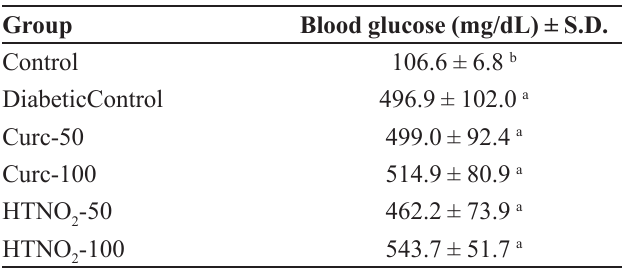
FIGURE 4 - Changes in capillary blood glucose levels of animals throughout the experimental period. Control = control group,non- diabetic; Diabetic Control = diabetic control group, diabetic; Curc-50 = group Curc-50, diabetic, curcumin 50 mg/kg of body weight by oral gavage; Curc-100 = group Curc-100, diabetic,curcumin 100 mg/kg of body weight by oral gavage; HTNO group HTNO -50, diabetic, HTNO 50 mg/kg of body weight by oral gavage; HTNO 2 2 100 mg/kg of body weight by oral gavage. TABLE II - Capillary blood glucose levels of animals at the end of experiment (week 5) Group Blood glucose (mg/dL) ±